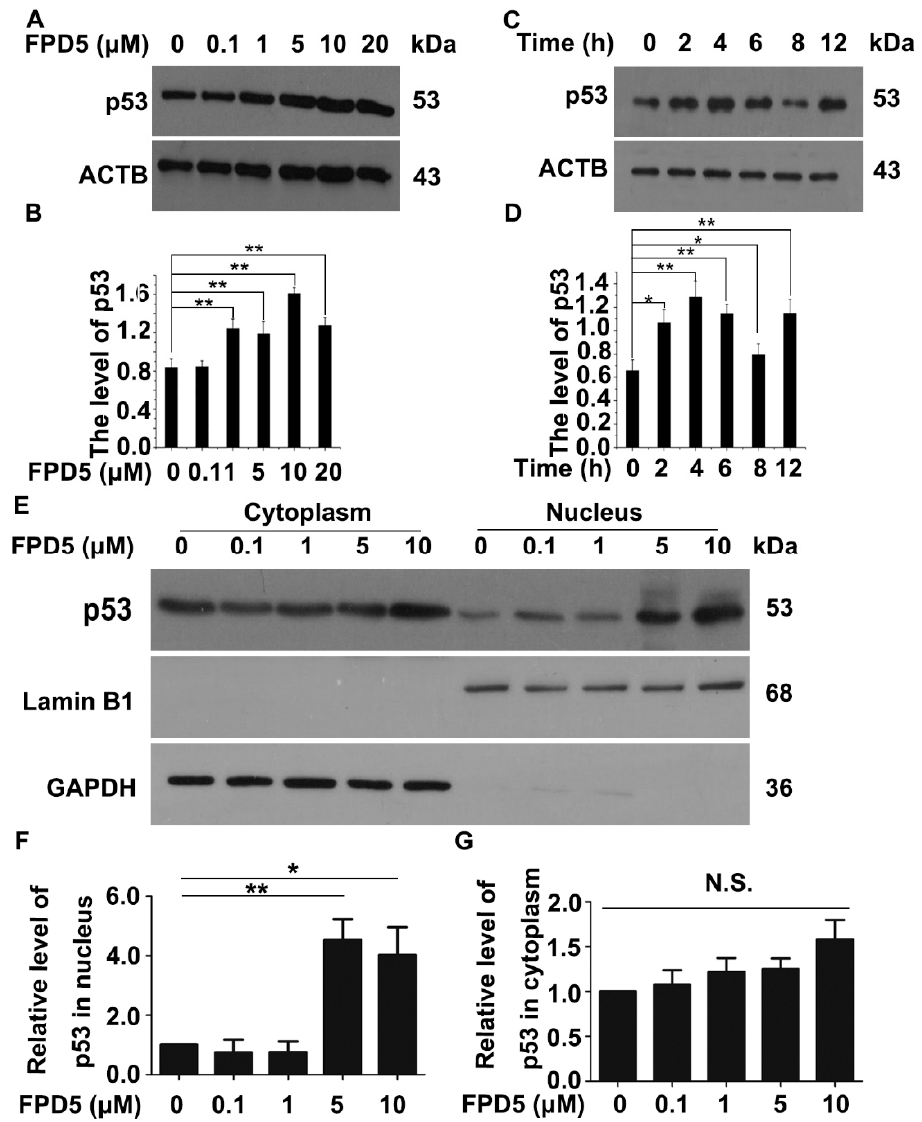
Figure 1. FPD5 increased the protein level of p53 in the nucleus of A549 cells. ( A , B ) The influence of different concentrations of FPD5 (0, 0.1, 1, 5, 10, 20 μ M) for 24 h on the protein level of p53 in the A549 cell line was analyzed by Western blot. ( C , D ) A549 cells were treated with 5 μ M FPD5 for 2, 4, 6, 8, and 12 h. The protein level of p53 was examined by Western blot. ( E – G ) The A549 cell line was treated with FPD5 (0, 0.1, 1, 5, 10 μ M) for 24 h. The nucleus and cytoplasm were extracted for Western blot, respectively. Data are mean ± SEM. * p < 0.05, ** p < 0.01, N.S., not significant, n = 3.